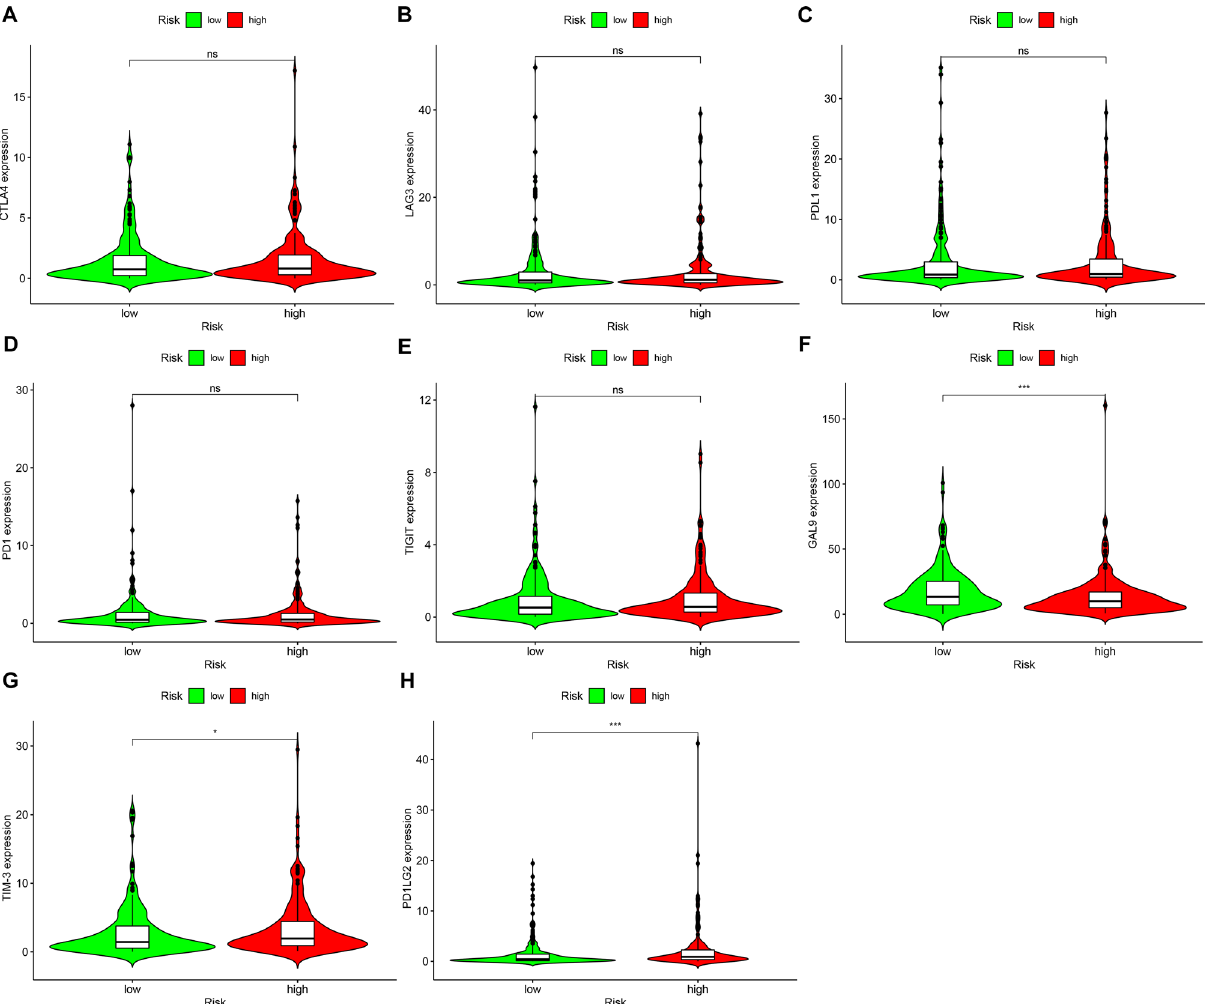
Figure 7. Correlations between risk model and immune checkpoints in bladder cancer. Comparing the expressions of ( A ) CTLA4; ( B ) LAG3; ( C ) PDL1; ( D ) PD1; ( E ) TIGIT; ( F ) GAL9; ( G ) TIM-3 and ( H ) PD1LG2 in high and low bladder cancer subjects. Ns: not significant; *p < 0.05; ***p <